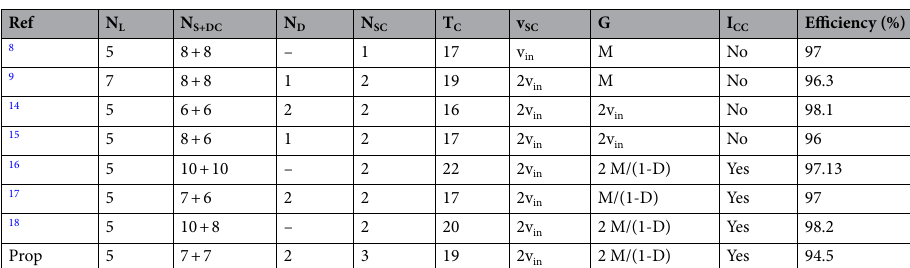
Table. 2. Summary Comparison. N L -Number of level, N S+DC -Number of switch and driver circuits, N D - number of diodes,